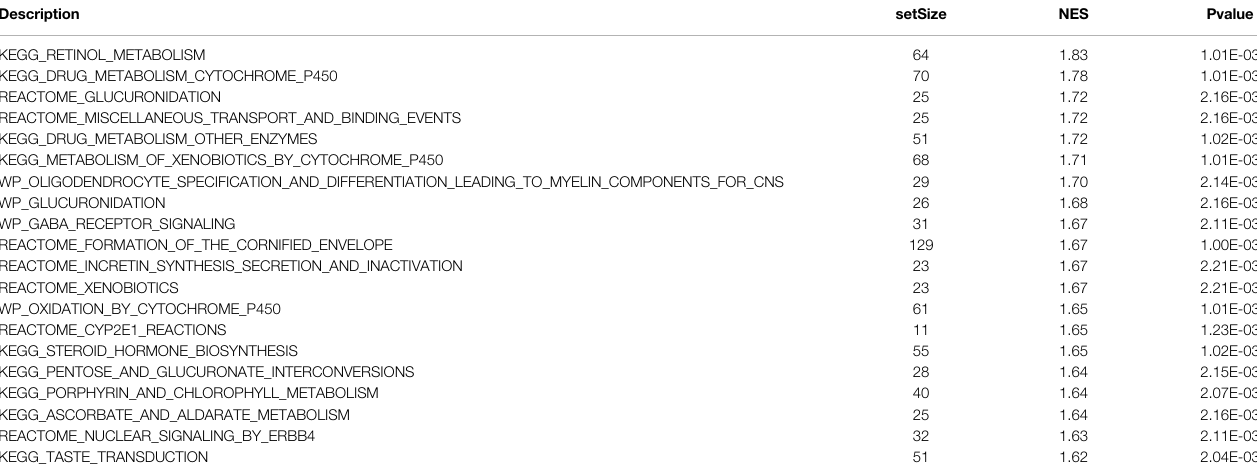
TABLE 3 | GSEA of DEGs in the MDN1 mutant and wild-type groups.